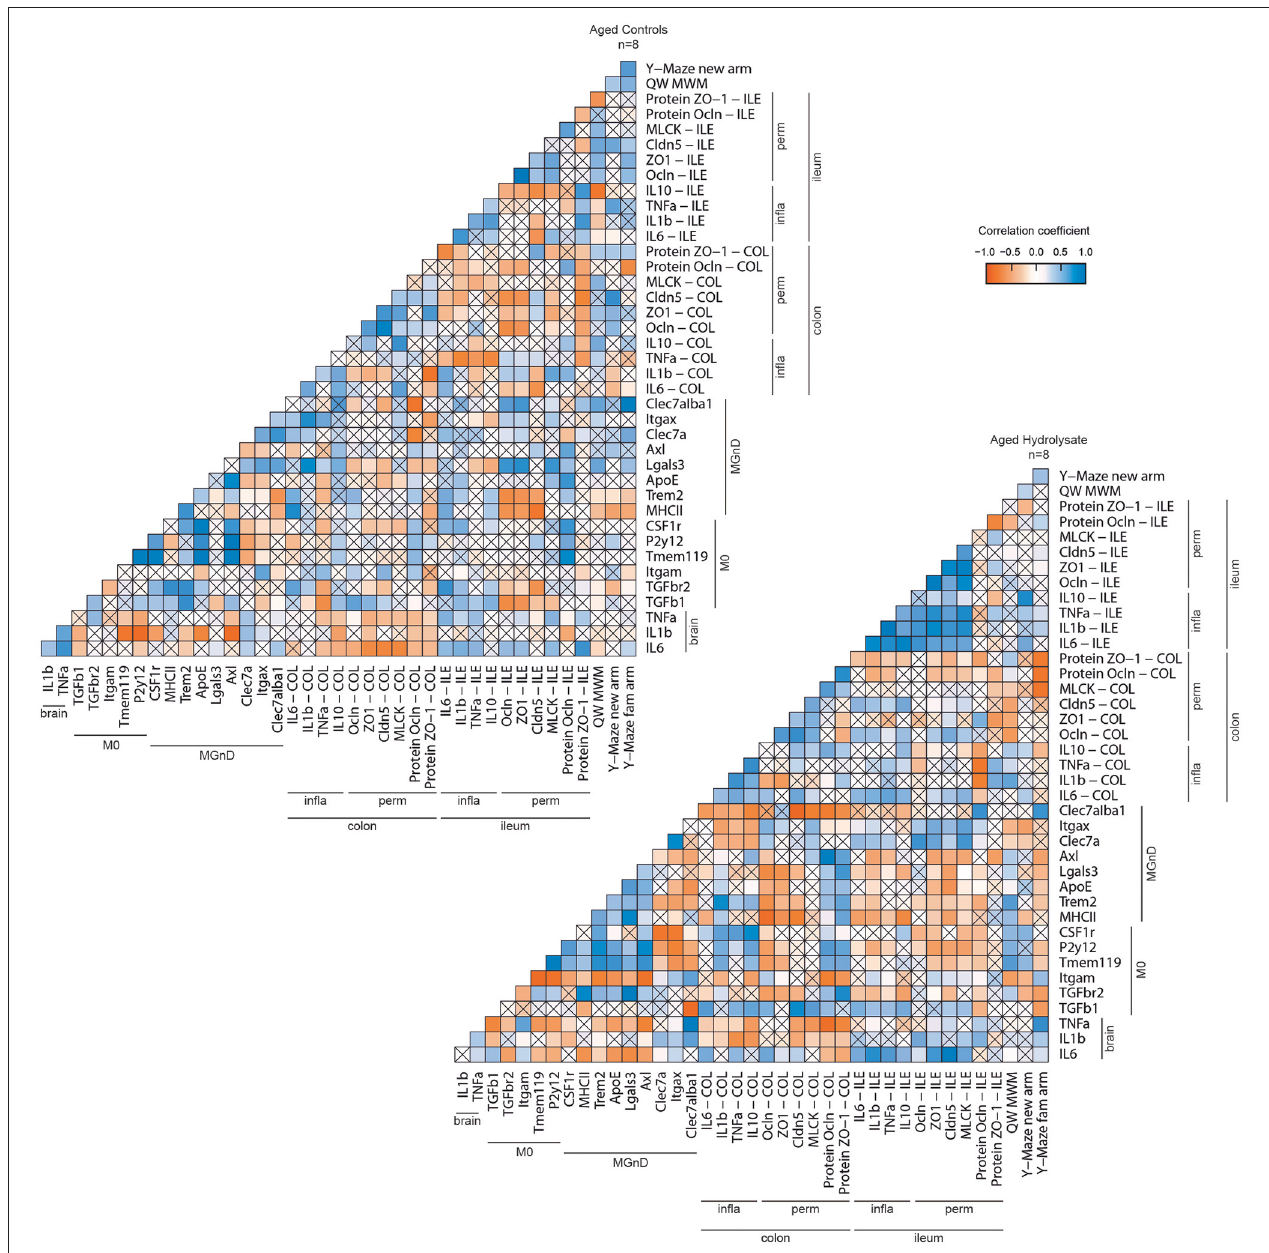
FIGURE 11 | Correlation matrix of behavioral and biochemical parameters of each group. Positive correlations are represented in blue, negative correlations in red. No significant correlations are represented by a